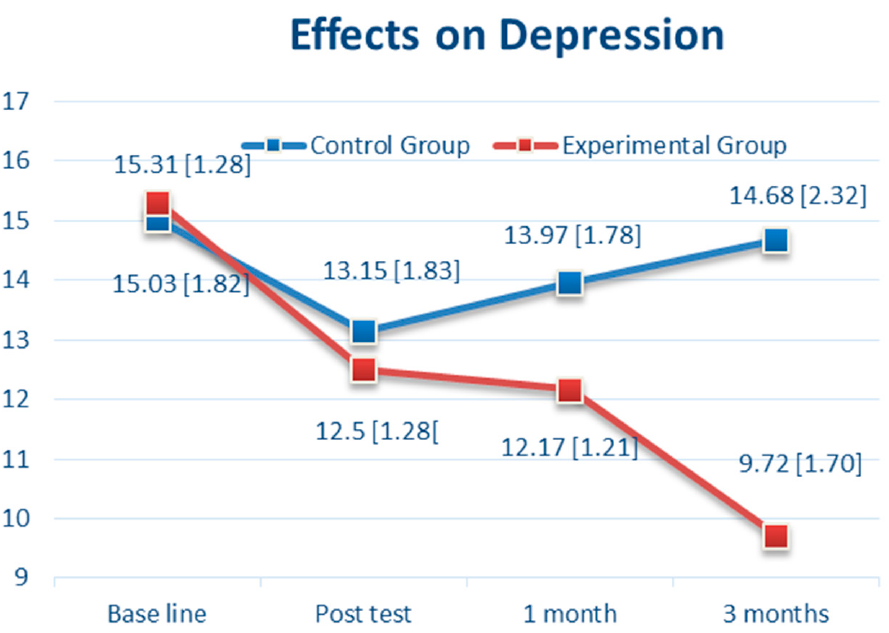
Figure 4. The Effects over Time of Cognitive Behavioral Therapy (CBT) on Depression.